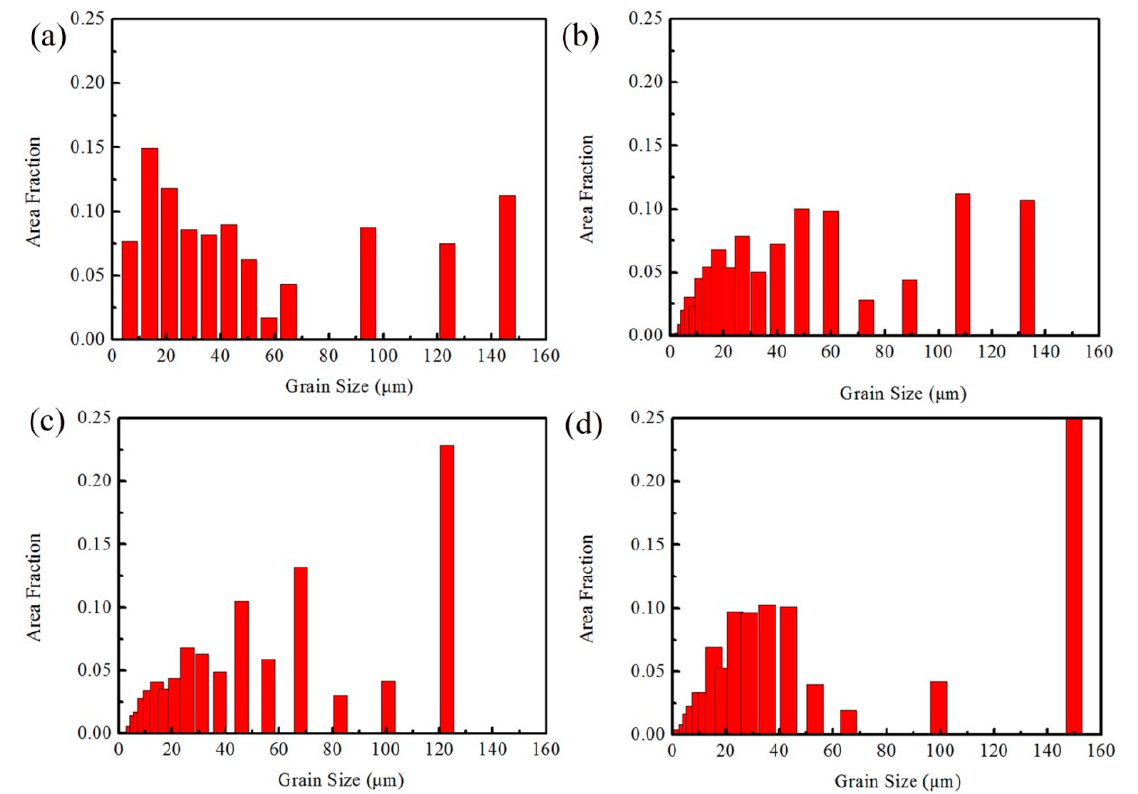
Figure 4. Statistical diagrams of the grain-size of the joint regions for different aging times: ( a ) 5 h, ( b ) 20 h, ( c ) 100 h, and ( d ) 500 h.